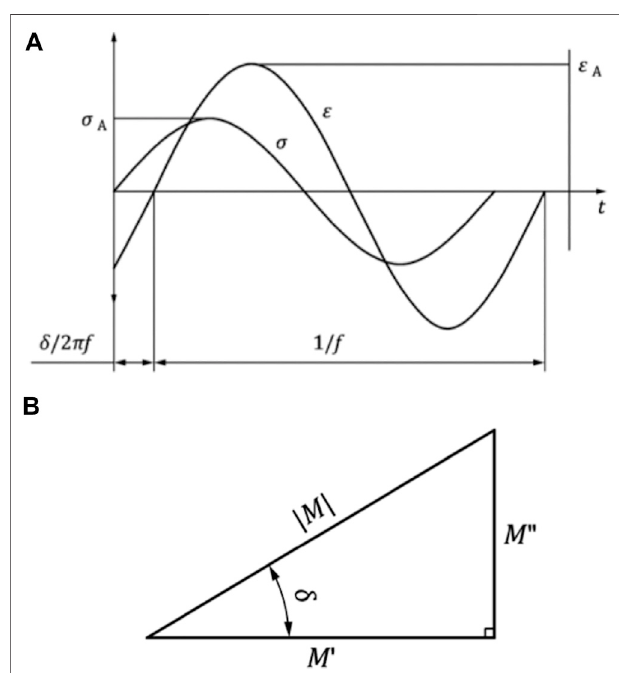
FIGURE 5 | (A) Representative force-induced sinusoidal oscillation (F) and therespectivede fl ectionresponse(l)ofaviscoelasticmaterial.Thetime-dependent, characteristic shift ( δ /2 π f) of the force (F A ) versus the de fl ection (l A ) amplitudes areplottedoverthetime(t). (B) RelationbetweenthestoragemodulusM ′